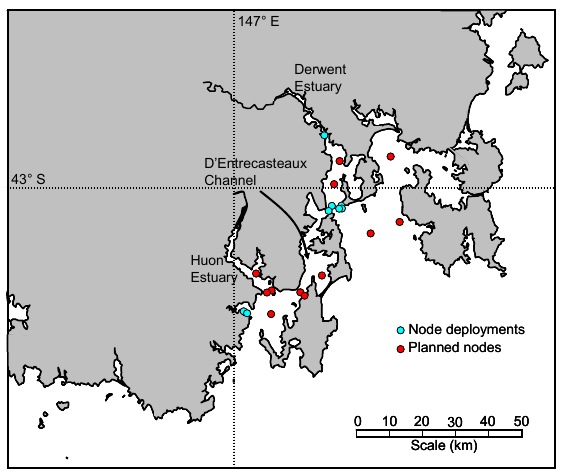
Figure 1. Location of node deployments and planned nodes in the TasMAN